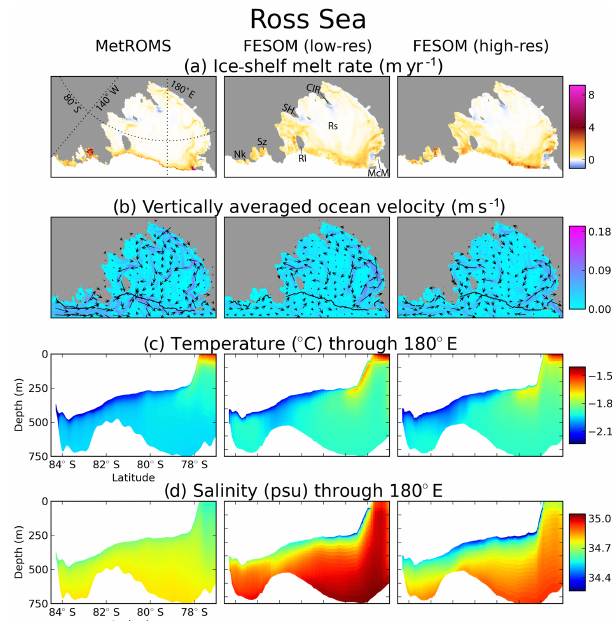
Figure 15. (a, b) As Fig. 11a and b for the Ross Sea ice-shelf cav- ities. (c) Temperature ( ◦ C) and (d) salinity (psu) interpolated to 180 ◦ E, through the Ross Ice Shelf. Rs indicates Ross Ice Shelf, Sz indicates Sulzberger Ice Shelf, Nk indicates Nickerson Ice Shelf, McM indicates McMurdo Ice Shelf, RI indicates Roosevelt Island, CIR indicates Crary Ice Rise, and SH indicates Steershead Ice